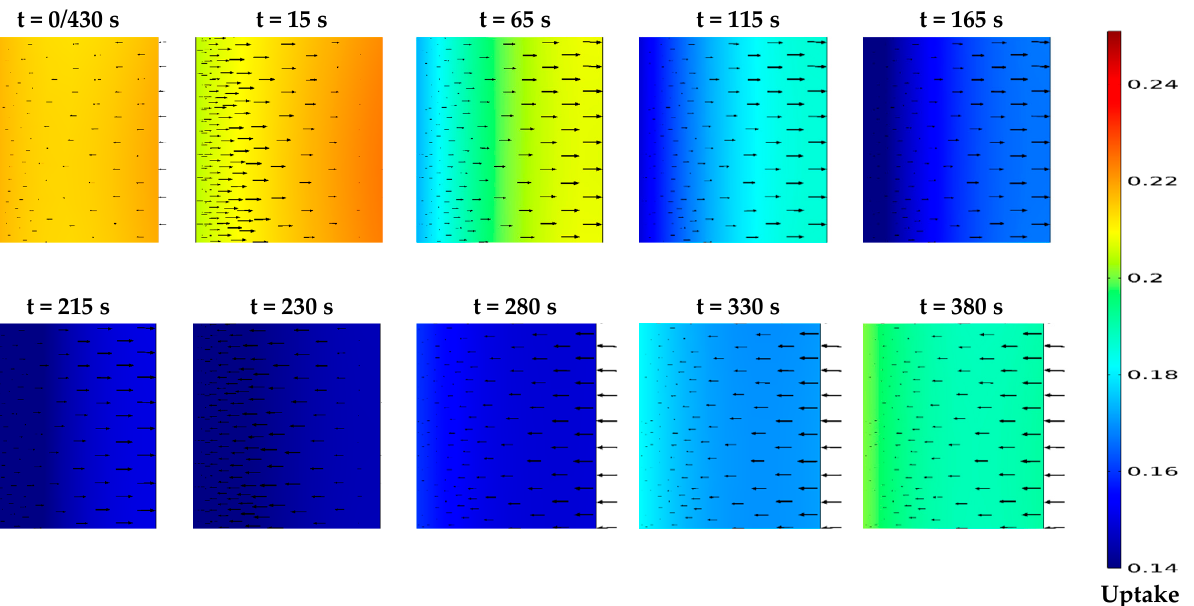
Figure 6. The uptake distribution during the whole cycle at different time steps for the consolidated form.